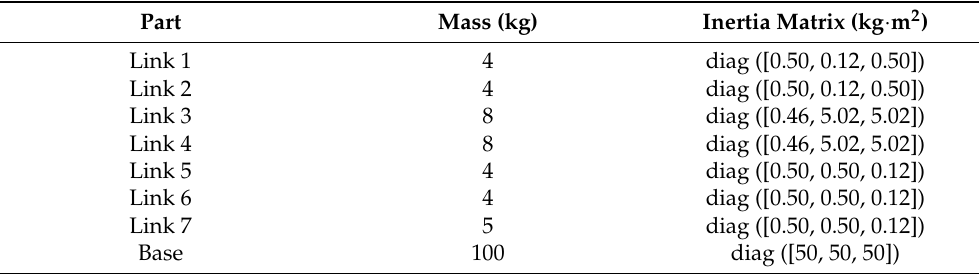
Figure 9. A 7-DOF free-floating space robot. Table 2. Dynamics parameters.